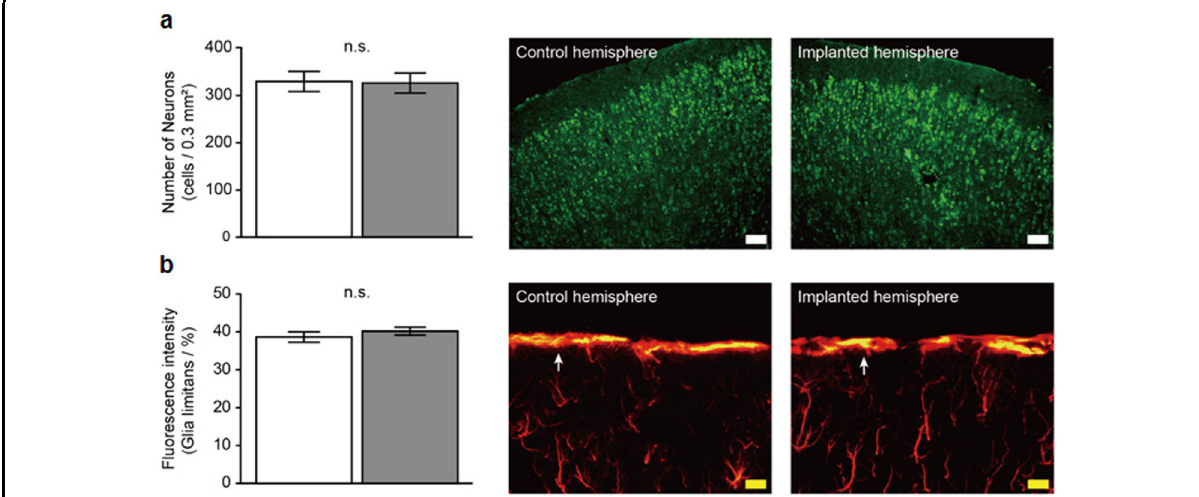
Fig. 6 Immunohistochemistry data for the biocompatibility of the hybrid graphene multichannel electrode. a No difference was observed in the number of neurons (labeled with NeuN, a neuronal molecular marker) between implanted (gray) and control (white) hemispheres of awake animals (scale bar = 100 μ m). b No difference was observed in the number of glia (labeled with GFAP, a glia molecular marker) between implanted (gray) and control (white) hemispheres of the awake animals (scale bar = 20 μ m). The arrows indicate glia limitans, the index for brain in fl ammation. Data are expressed as the mean ± SEM. n.s. not signi fi